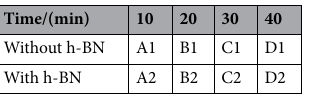
Table 1. Experimental measurement